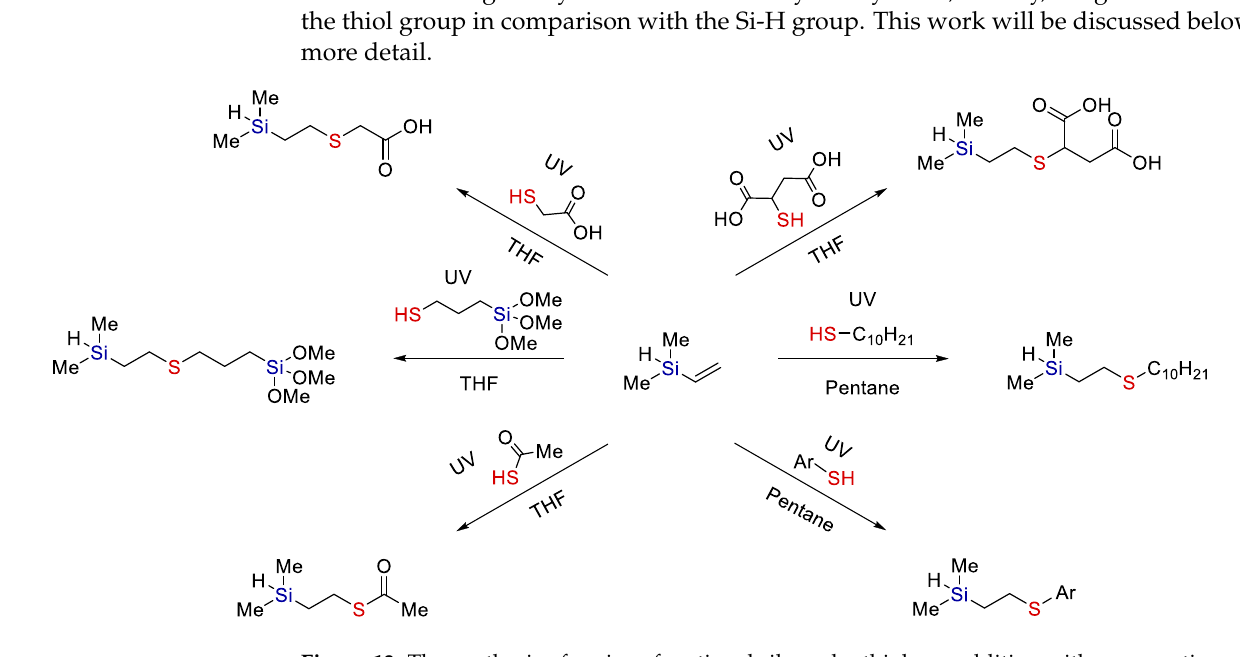
Figure 13. The synthesis of various functional silanes by thiol-ene addition with preservation of the Si-H bond [42]. Adopted from Ref.